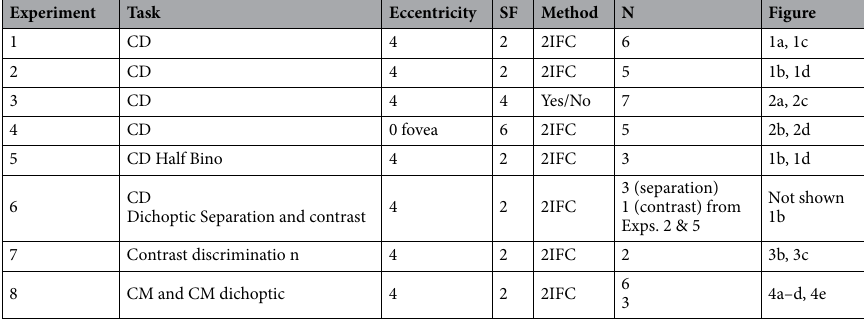
Table 1. Details of the experimental design. CD contrast detection, CM contrast matching, SF spatial Frequency, 2IFC two interval force